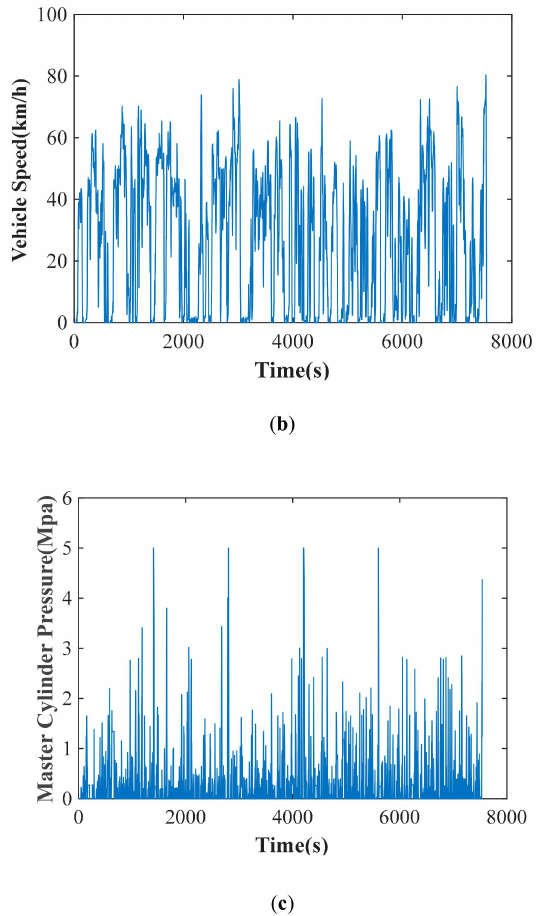
Figure 2. The test routes and signal profiles. ( a ) The cyclic test route (A → B → C → D → E → A). ( b ) Vehicle velocity profile. ( c ) Master cylinder pressure